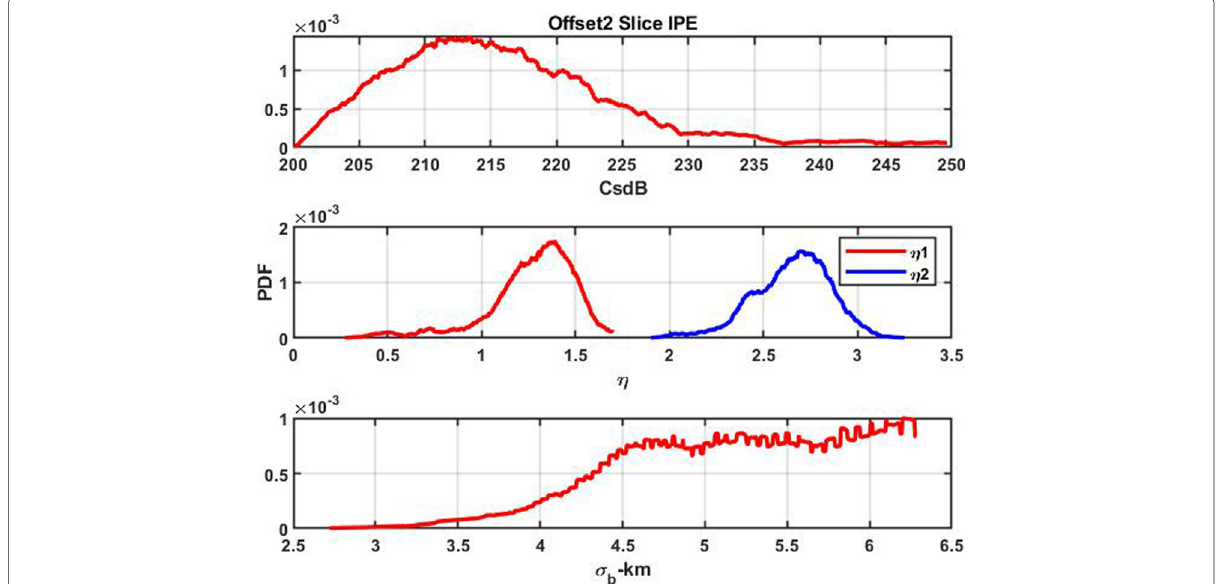
Fig. 14 Probability distributions of offset2 plane stochastic